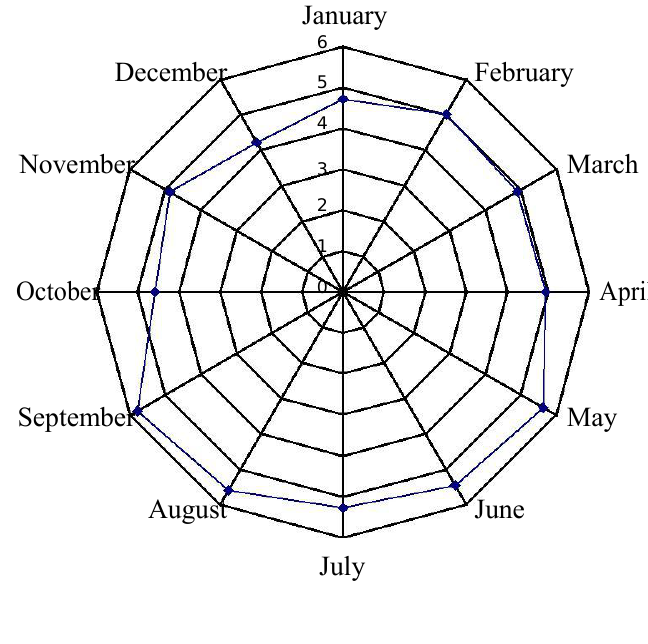
Figure 2. Monthly distribution of visits of schizophrenic patients in the Emergency center of the Regional dispenser in